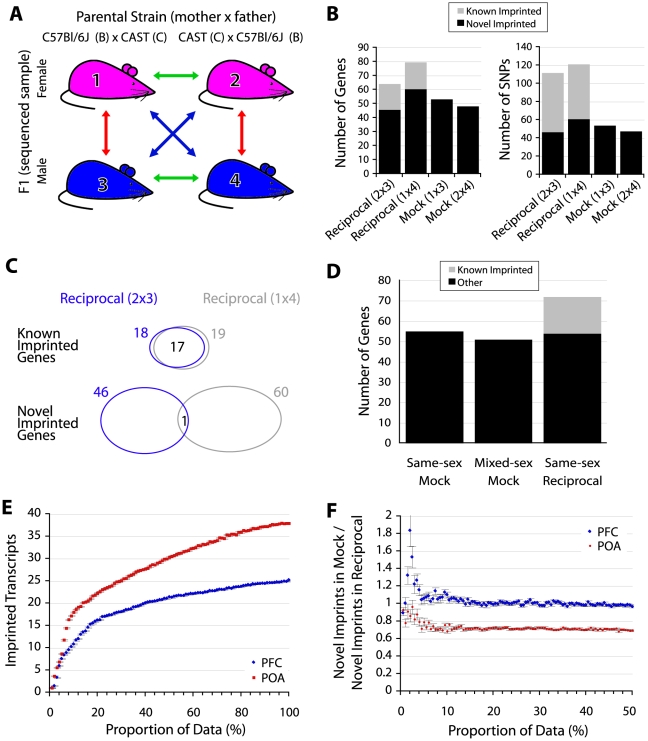
False discoveries explain the majority of novel imprinted genes.(A) Schematic of experimental design and mock (negative control) comparisons. The red arrows indicate mock comparisons, green arrows indicate same-sex reciprocal comparisons, while blue arrows indicate mixed-sex reciprocal comparisons. (B) Number of SNPs/genes that exceed threshold used by [16], [17] in reciprocally crossed and mock PFC samples. (C) Agreement on known and novel imprinted genes detected in the two reciprocal comparisons shown in 2B. (D) Number of genes exceeding the threshold used in [16], [17] in a mock cross between E17.5 brains from embryos of the same sex (males) is not significantly different from mock comparison of opposite sexes. (E) Relationship between read depth and sensitivity (number of transcripts reaching significance). Aligned reads from the same cross (1+3 and 2+4) were selected at random in equal proportions for each sample (see Materials and Methods). Average values for 100 sampling iterations (+/− standard error) are shown. (F) Proportion of novel imprinted genes estimated to be false-positives as a function of input read depth adjusted by random sampling (see Materials and Methods). Average values for 100 sampling iterations (+/− standard error) are shown.